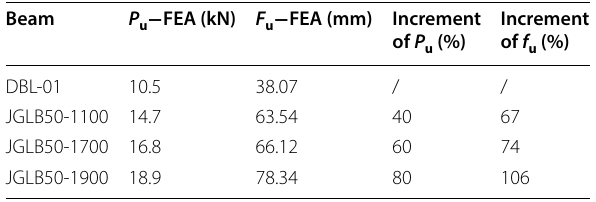
P u is ultimate load; f u is deflection of mid-span